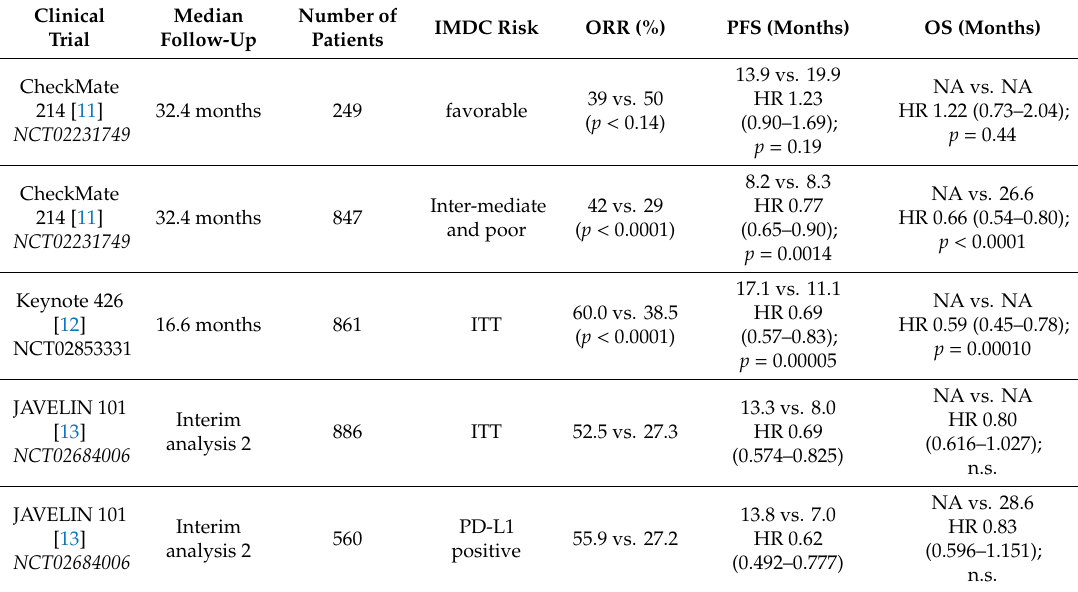
Table 1. Results of pivotal studies with PD-1 / PD-L1 checkpoint inhibitors for first-line treatment of advanced or metastatic renal cell